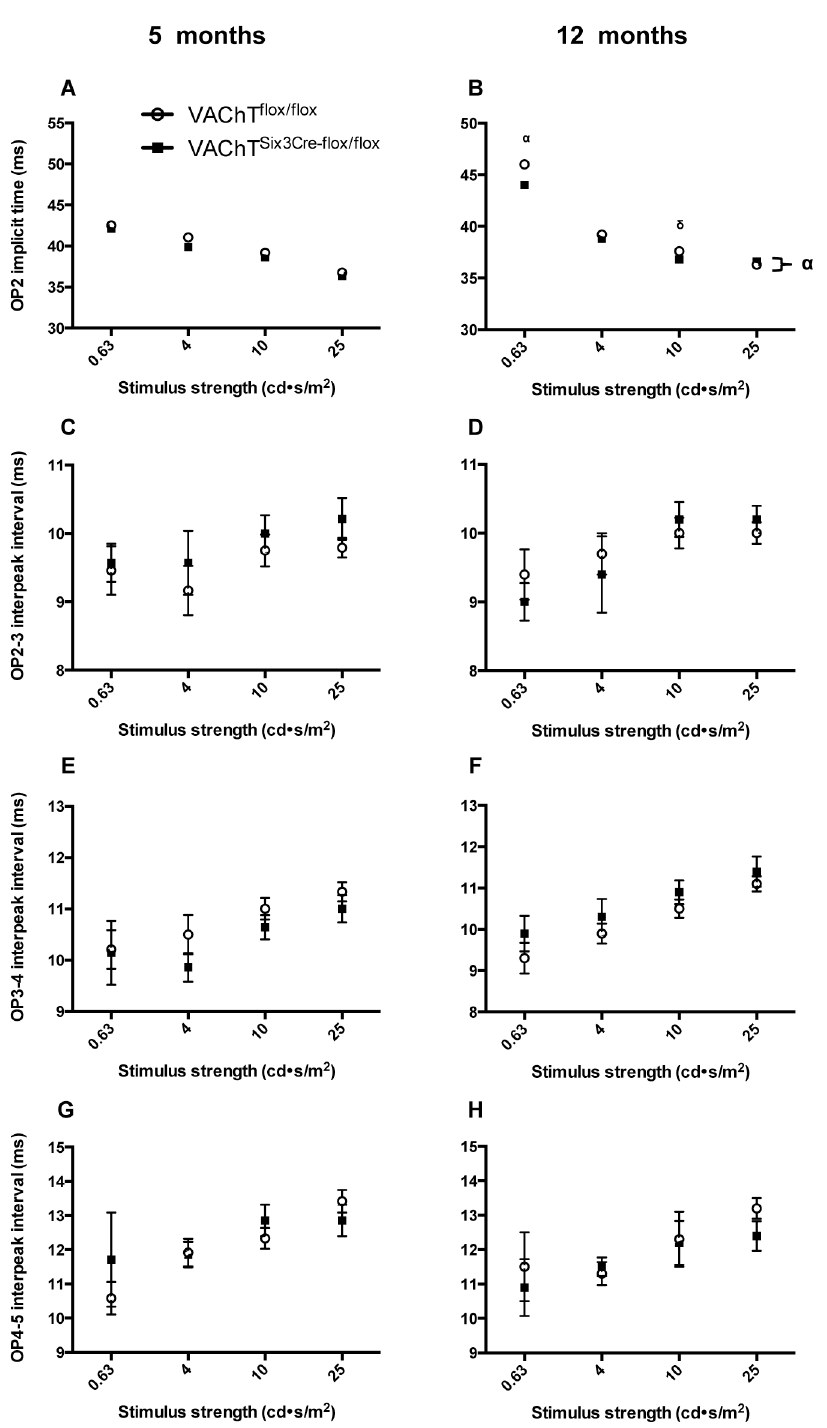
Fig 9. Assessment of oscillatory potential implicit times. Implicit times of OP peaks assessed in VAChT Six3-Cre-flox/flox mice (open circles) and littermate controls (VAChT flox/flox , closed squares) at either 5 (VAChT Six3-Cre-flox/flox , n = 7; control, n = 12) or 12 months of age (VAChT Six3-Cre-flox/flox , n = 5; control, n = 5). The initial implicit time, measures time from stimulus onset to the peak of the first OP, is not different between genotypes at (A) 5 months of age, but is significantly reduced in VAChT Six3-Cre-flox/flox mice at (B) 12 months of age. The implicit times of OP3 (C-D), OP4 (E-F), and OP5 (G-H) are not different between genotypes at either age. δ , P < 0.05; α , P < 0.0001 versus control